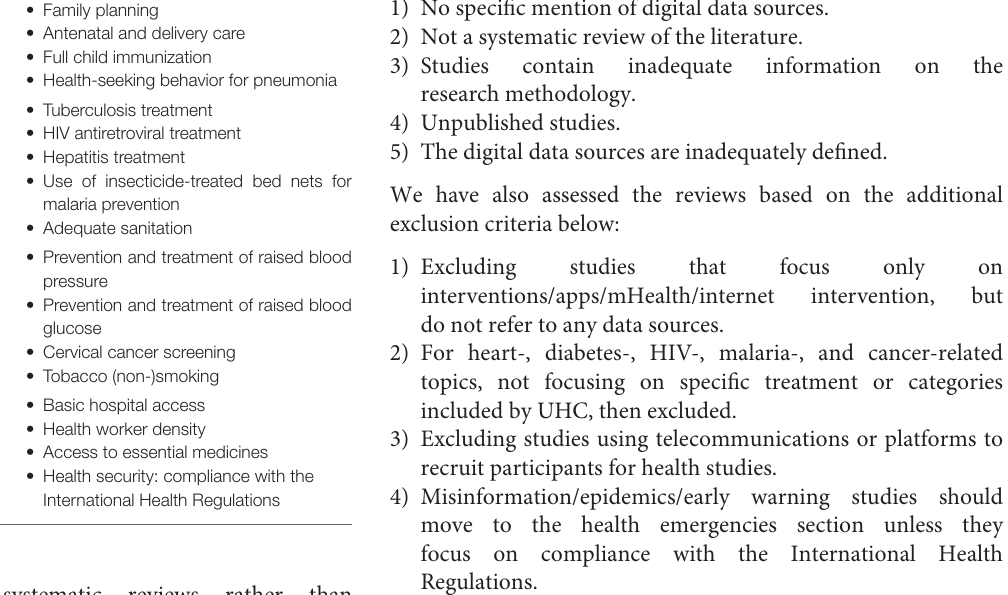
Frontiers in Public Health |